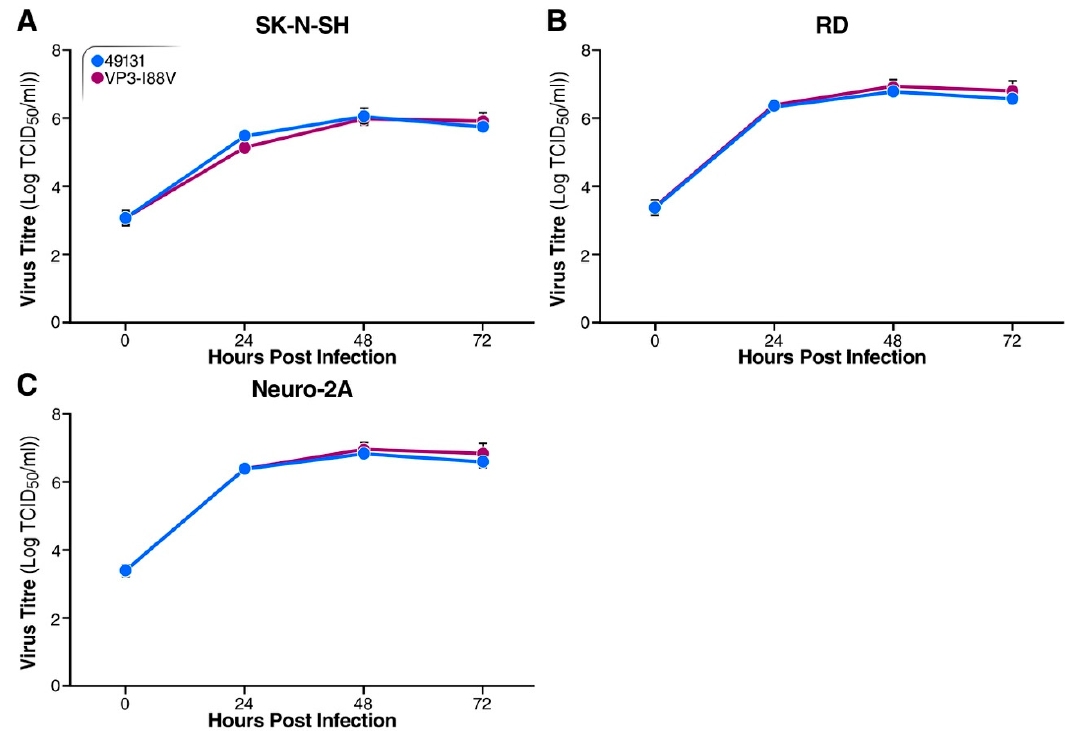
Figure 8. Replication analysis for 49131 and 49131-VP3-I88V in cell lines. SK-N-SH ( A ), RD ( B ) and Neuro-2A ( C ) cells were infected with 49131 or VP3-I88V at an m.o.i. of 0.01 in triplicate and harvested at indicated time points for TCID 50 assay to determine virus titers. Results of triplicates are shown as mean ± S.D.